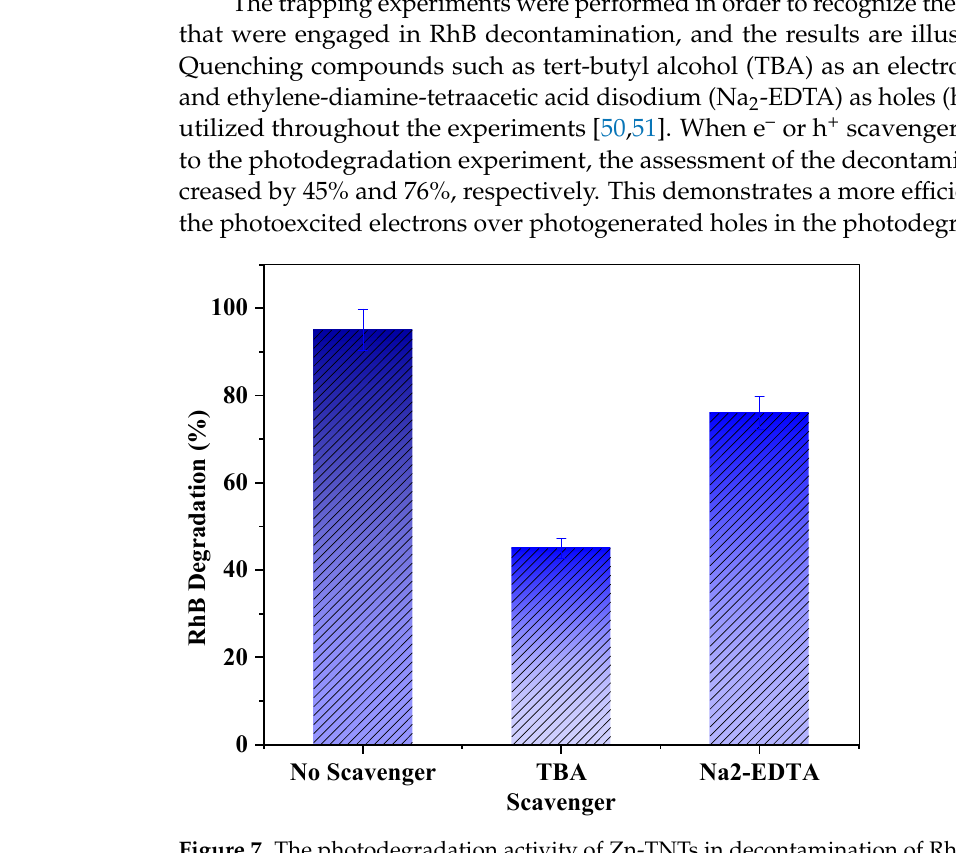
Figure 8. ( a ) Durability of Zn-TNTs in photodegrading RhB up to five runs under visible-light irradiation for 120 min, and ( b ) XRD patterns of Zn-TNTs before and after 5 consecutive runs.